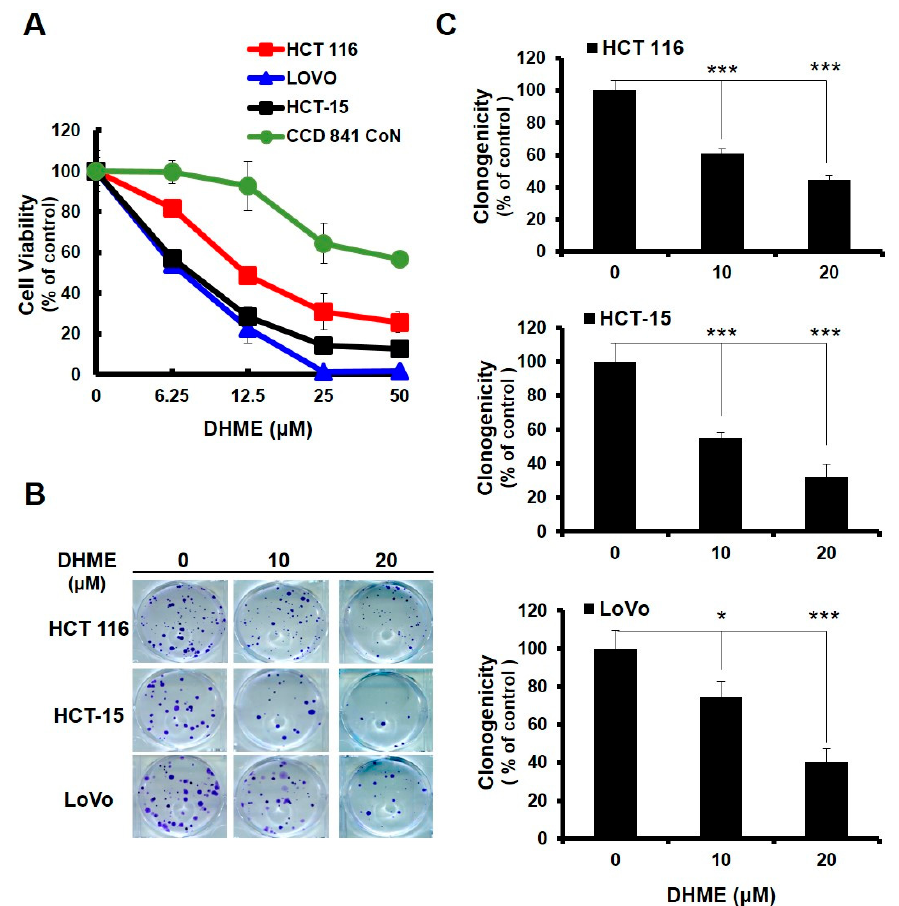
Figure 1. Anti-colorectal cancer (CRC) e ff ect of dehydroxyhispolon methyl ether (DHME). ( A ) Selective cytotoxicity of DHME against malignant but not normal human colorectal epithelial cell lines. A panel of human CRC cell lines, such as HCT 116, HCT-15, and LoVo, in addition to one normal human colorectal epithelial cell line, CCD 841 CoN, were treated with DHME for 48 h, followed by cell viability evaluation using MTS assay. ( B ) DHME suppresses CRC cells to form colonies. A total of 2 × 10 2 of human CRC cells, after 24 h of treatment with DHME, were allowed to grow in drug-free media for 10 days to form colonies, which were visualized by crystal violet staining. ( C ) Quantitative analysis of DHME-induced suppression of CRC clonogenicity. Colonies displayed in (B) were scored, and the results were subjected to statistical analysis. * p < 0.05; *** p <